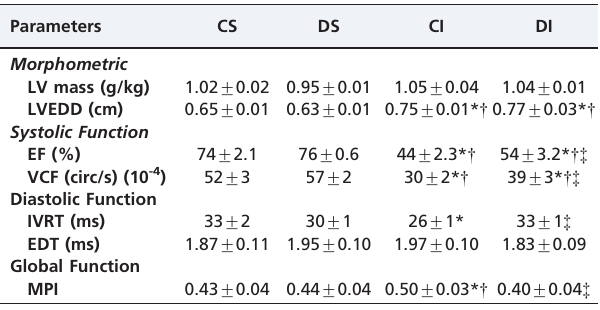
Table 1 - Left ventricular morphometry and function one week after myocardial infarction and three weeks after STZ-induced